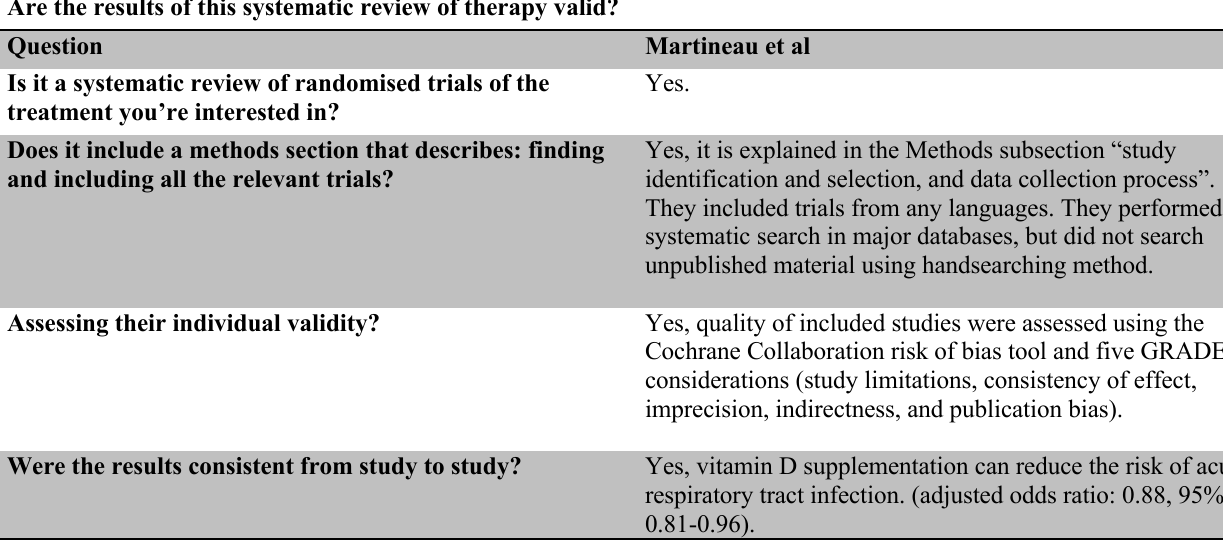
Table 4. Validity assessment of meta-analysis by Martineau et al Are the results of this systematic review of therapy valid? Is it a systematic review of randomised trials of the treatment you’re interested in?